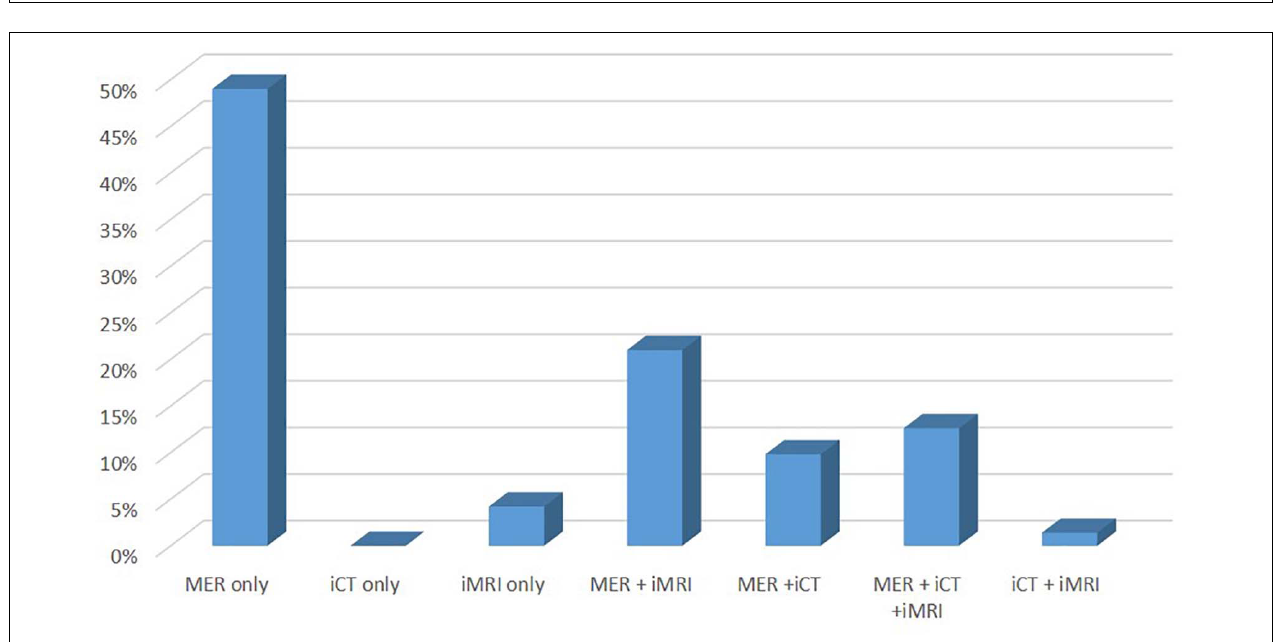
FIGURE 3 | Team members reported as a part of the “required” preoperative evaluation. Y-axis represents the percentage of respondents reporting involvement of that team member.